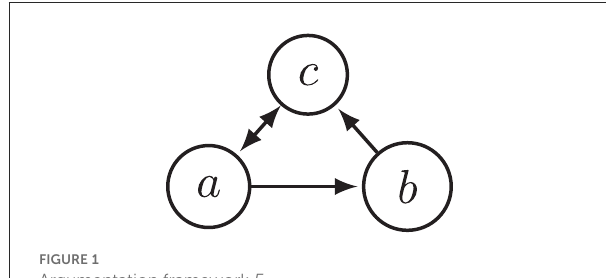
FIGURE1 Argumentation framework F 1